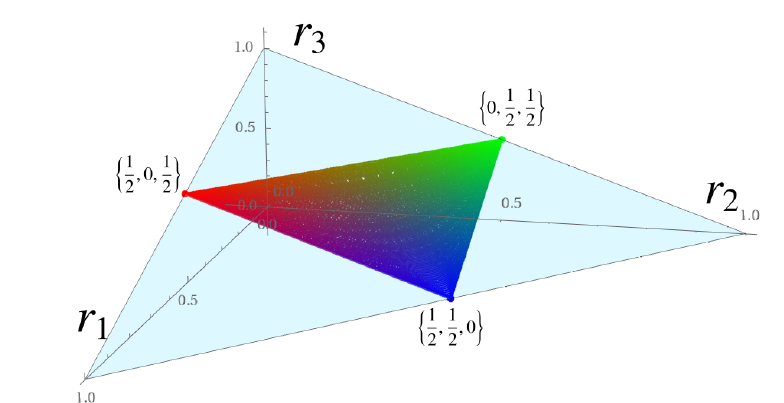
Figure 2. The 2-simplex ∆ 2 of R 3 (light-blue shaded plane), defined by the set of points ( r 1 , r 2 , r 3 ) satisfying r i ≥ 0 and ∑ i r i = 1. The 2-simplex δ 2 (colored central triangle) contains the subset of points of ∆ 2 that define the coefficients in the energy-expansion of initial states | ψ ( 0 ) (cid:105) that evolve towards a distinguishable state at time τ . The vertices of δ 2 correspond to elements of Family I-qubit, its edges to elements of Family I-b and its interior to elements of Family II. The colors in δ 2 identify the triads according to a RGB map-code defined by its